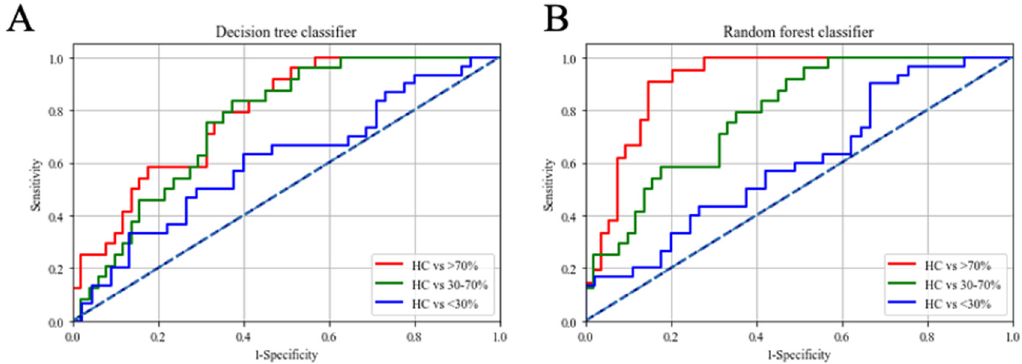
Figure 1. Comparison of the area under the receiver operating characteristic curve (AUC) of autoantibody isotypes against unmodified and malondialdehyde (MDA)-modified peptides in coronary artery disease (CAD) patients compared to healthy controls (HCs) with a decision tree classifier ( A ) and random forest classifier ( B ). Table 3. Comparison of AUC, sensitivity, and specificity of autoantibody isotypes against unmod- ified and malondialdehyde (MDA)-modified peptides in CAD patients compared to HCs with a decision tree classifier ( A ) and random forest classifier ( B ).